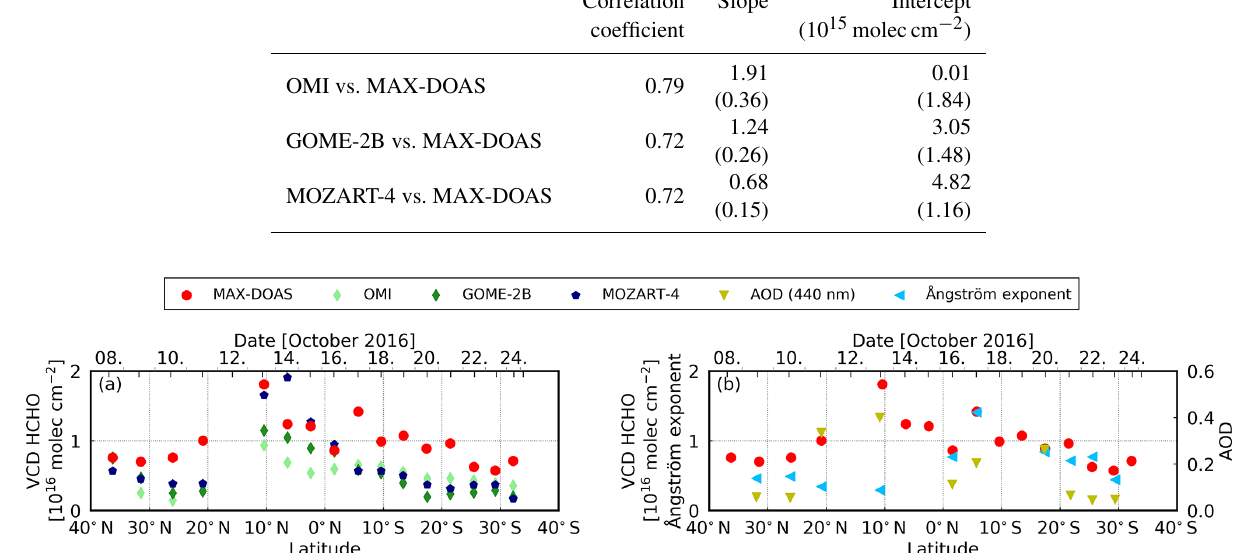
Figure 10. Daily mean HCHO VCDs over the Atlantic Ocean over the course of the cruise (from north to south). (a) Enhanced HCHO values can be observed in the area of expected outflow. Satellite observations and model values are also enhanced in this area. (b) The AOD and Ångström exponent from AERONET measurements are partly enhanced in these areas, depending on the source region.